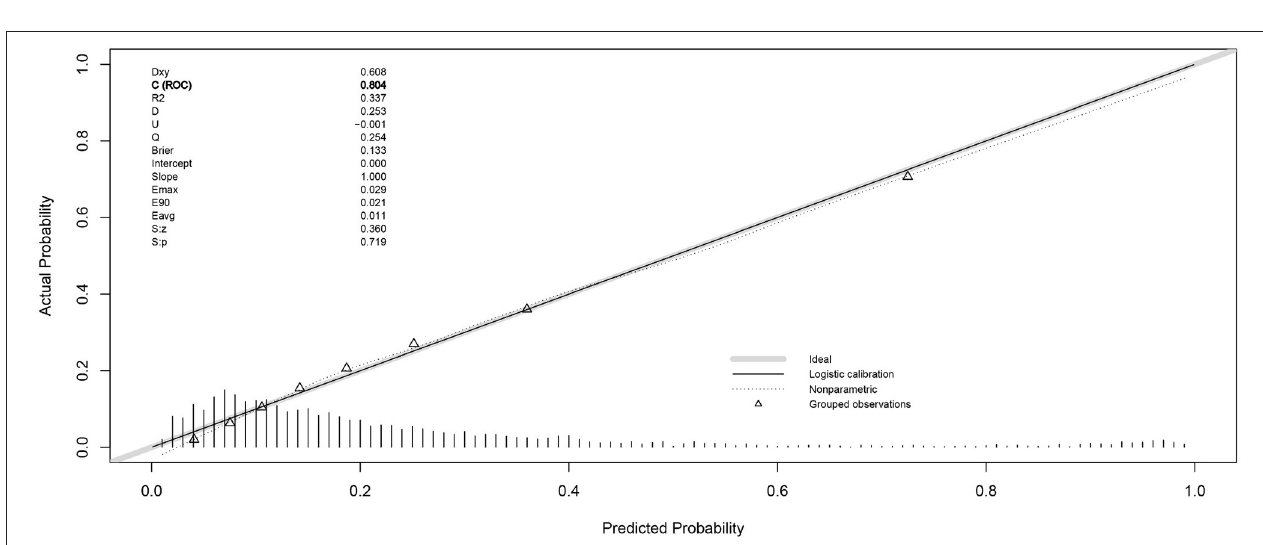
FIGURE 2 | Cross-validated calibration plots of the prediction model in risk of smartphone addiction. The smaller distance of the scatter points from the dotted line, the better calibration